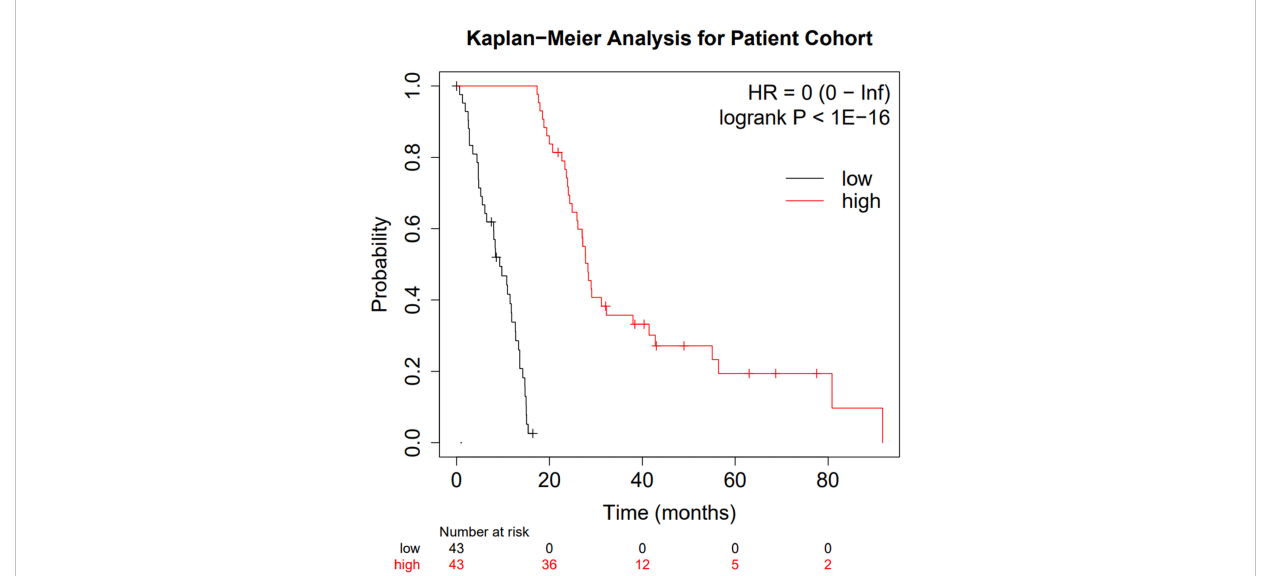
FIGURE 2 Kaplan-Meier curve comparing the two patient subgroups. Low surviving patients are shown in black whilst high-surviving patients are shown in